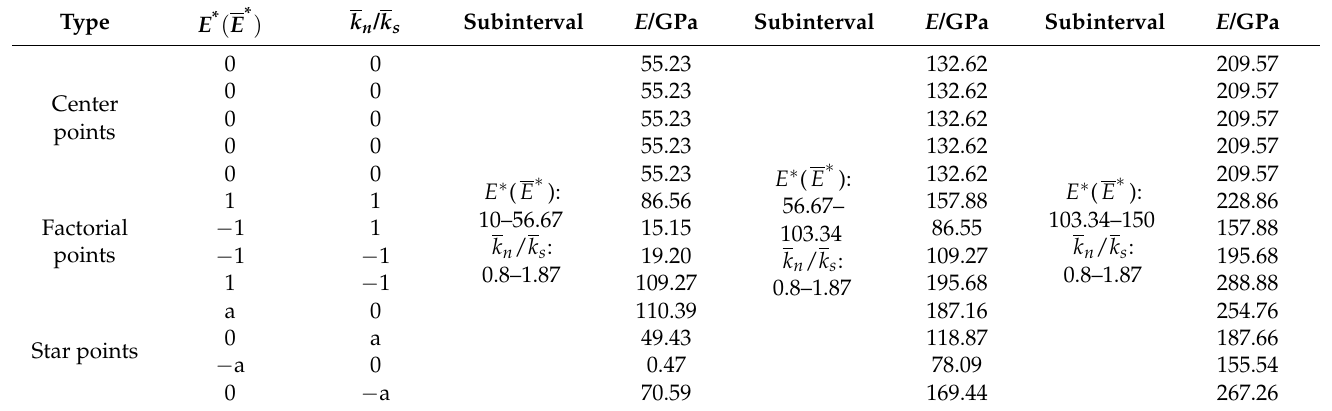
Table 5. CCD test scheme and calculation results of elastic modulus.